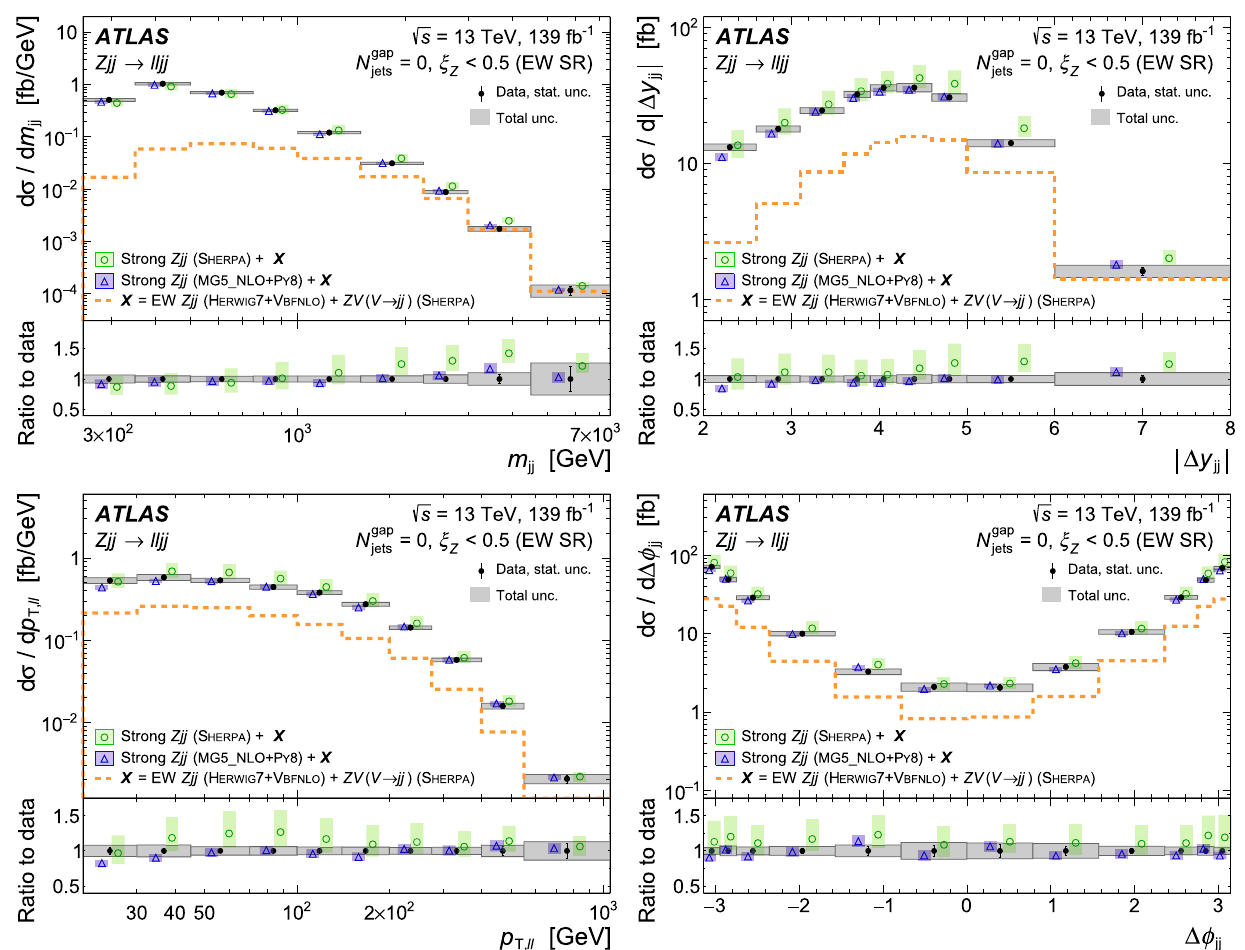
Fig. 8 Differential cross-sections measured in the SR for inclusive Zjj production as a function of m jj (top left), | (cid:4) y jj | (top right), p t ,(cid:3)(cid:3) (bottom left) and (cid:4)φ jj (bottom right). The unfolded data are shown as black points, with the statistical uncertainty represented by an error bar and the total uncertainty represented as a grey band. The data are compared with theoretical predictions constructed from different strong Zjj predictions provided by Sherpa (green) and MG5_NLO+P y 8 (blue). Uncertainty bands are shown for the two theoretical predictions. Each theory prediction is slightly offset from the bin center to avoid